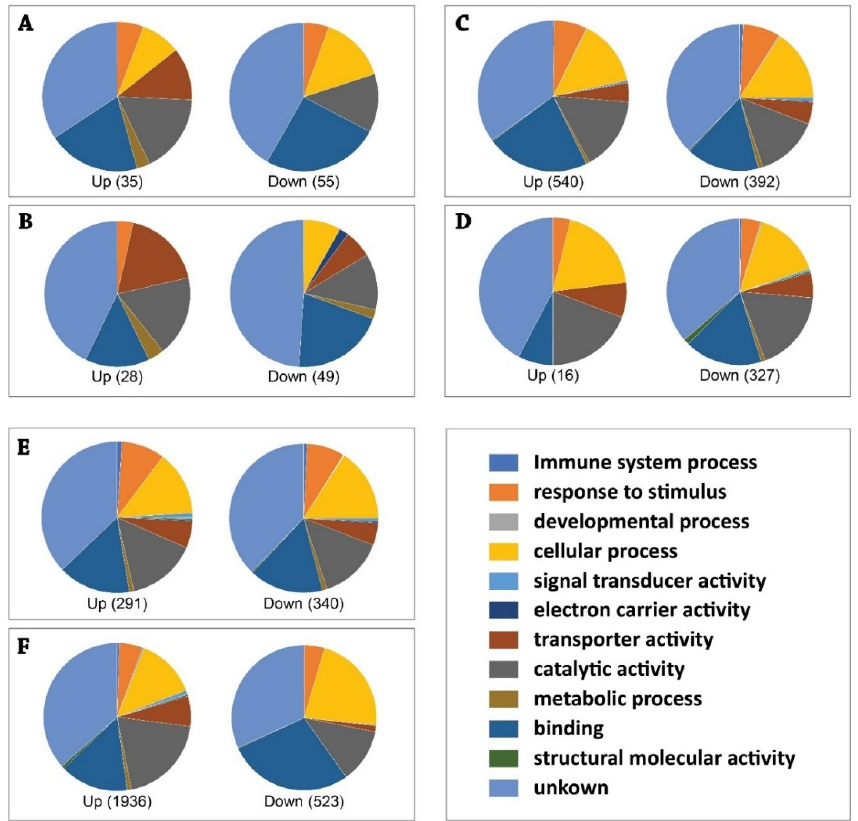
Figure 3. Overview of the functional categories of differentially expressed (DE) transcripts in response to ZIKV infection and between the permethrin resistant (KW) and susceptible (OR) strains of Aedes aegypti blood-feeding control. DE transcripts were determined based on statistical analysis by DESeq package. The total number of DE transcripts for each comparison is shown in parentheses in each figure. Gene ontology analysis of DE genes was performed based on the database of AmiGO 2 (http://amigo.geneontology.org/amigo), and pie charts were generated using Excel. Up, upregulated S1. GO analyses for RNA-seq data. ( A ) 12 h post injection KW-Control compared with